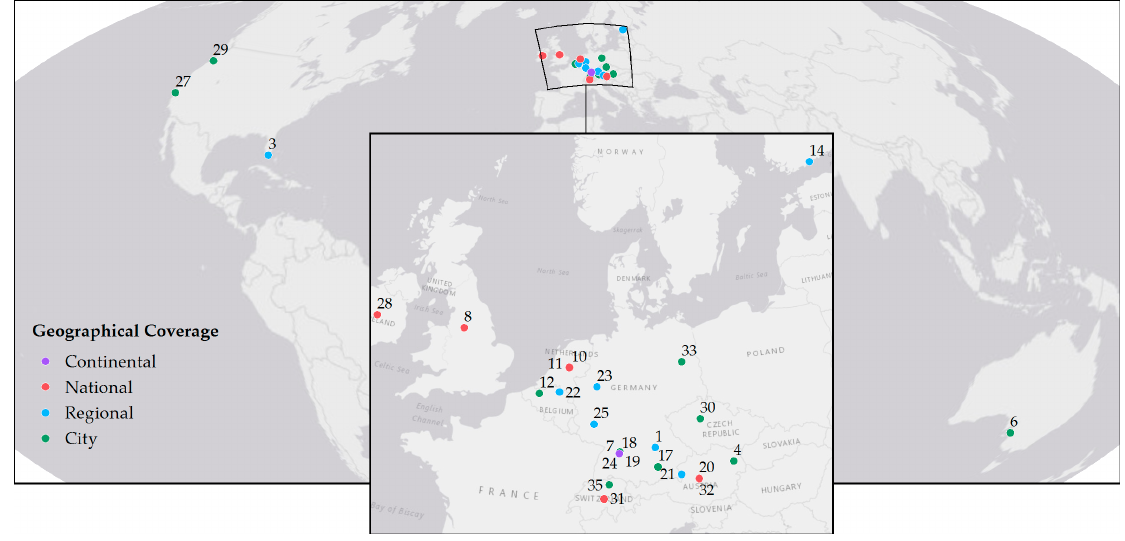
Figure 2. Geographic coverage of analyzed applications that do not provide a worldwide routing service.